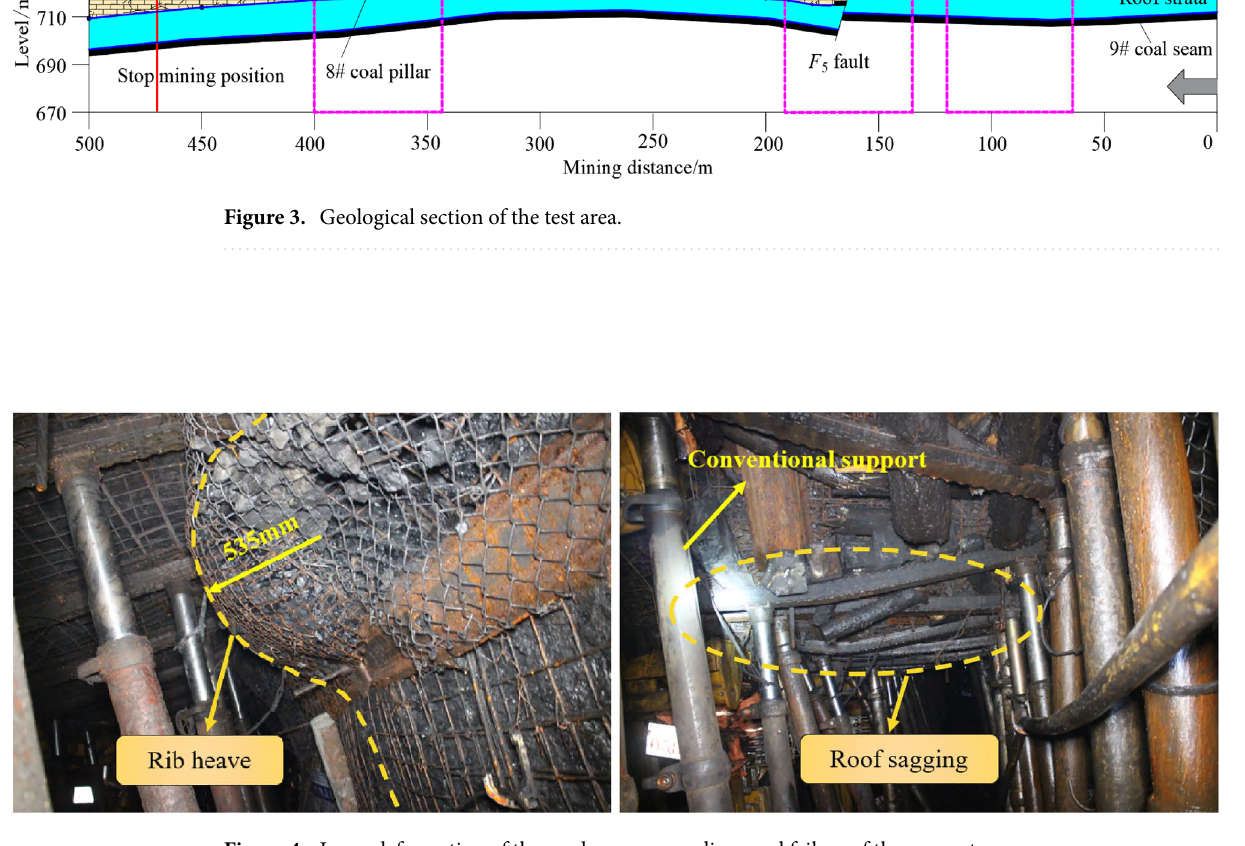
Figure 4. Large deformation of the roadway surroundings and failure of the